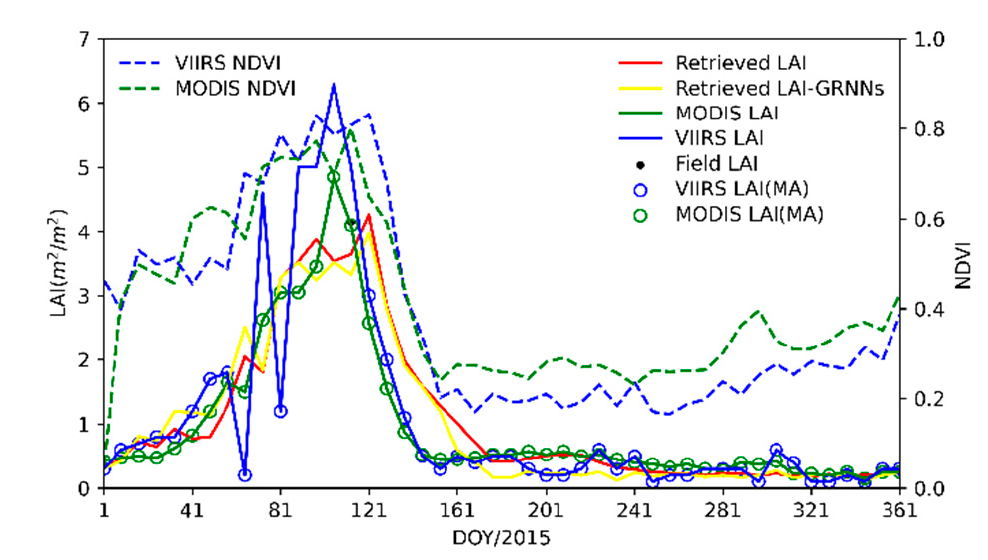
Figure 7. Temporal trajectories of the LAI-TCA and the LAI-GRNN at the center pixel of the Capi- tanata site for 2015.